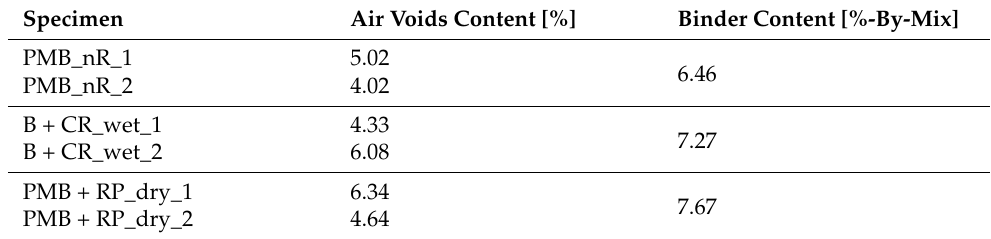
Table 4. Air voids content of the